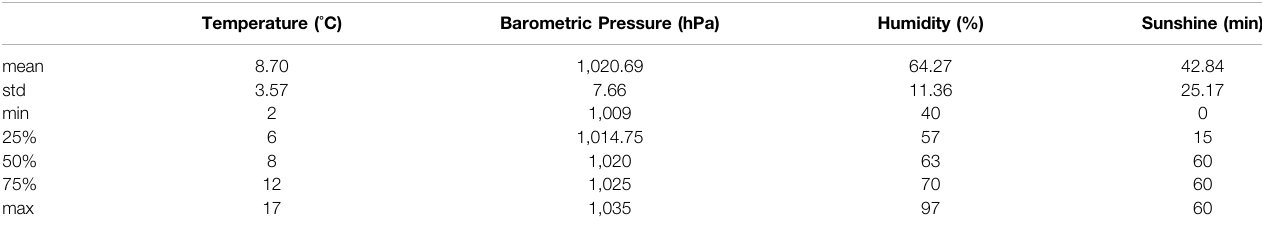
TABLE 1 | Mean values with minimum, maximum, standard deviation and CI for hourly weather data. Minutes of sunshine are minutes of a full hour. Temperature ( °